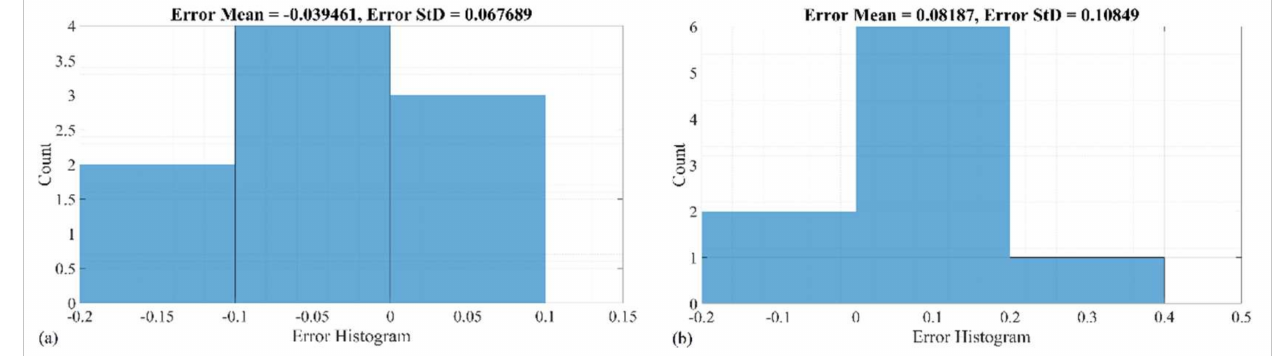
Figure 6. The error histogram of the data during the testing and training processes for ( a ) ANFIS-SR; ( b )